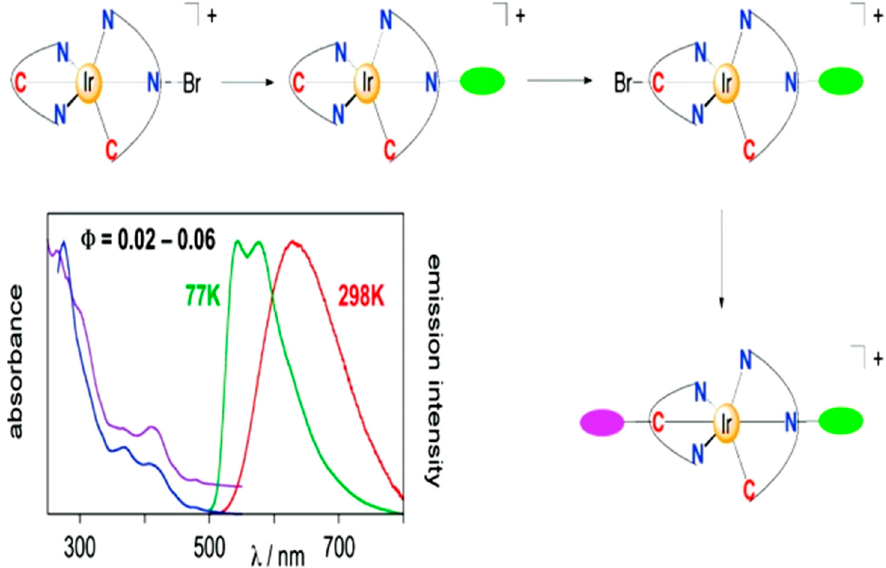
Figure 5. Schematic structural arrangement, absorption and emission properties of bis-terdentate [80], [Adapted with permission from (Whittle & Williams). Copyright (2006) American Chemical Society].